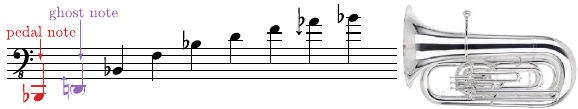
Figure 5. Natural notes playable by a B [ -contrabass tuba, that is to say without depressing any valves. From left to right: B [ 0 (pedal note), D1 (ghost note, naturally a bit sharp compared to an equal tempered scale), B [ 1, F2, B [ 2, D3, F3, A [ 3 (naturally a bit fl at compared to an equal tempered scale), B [